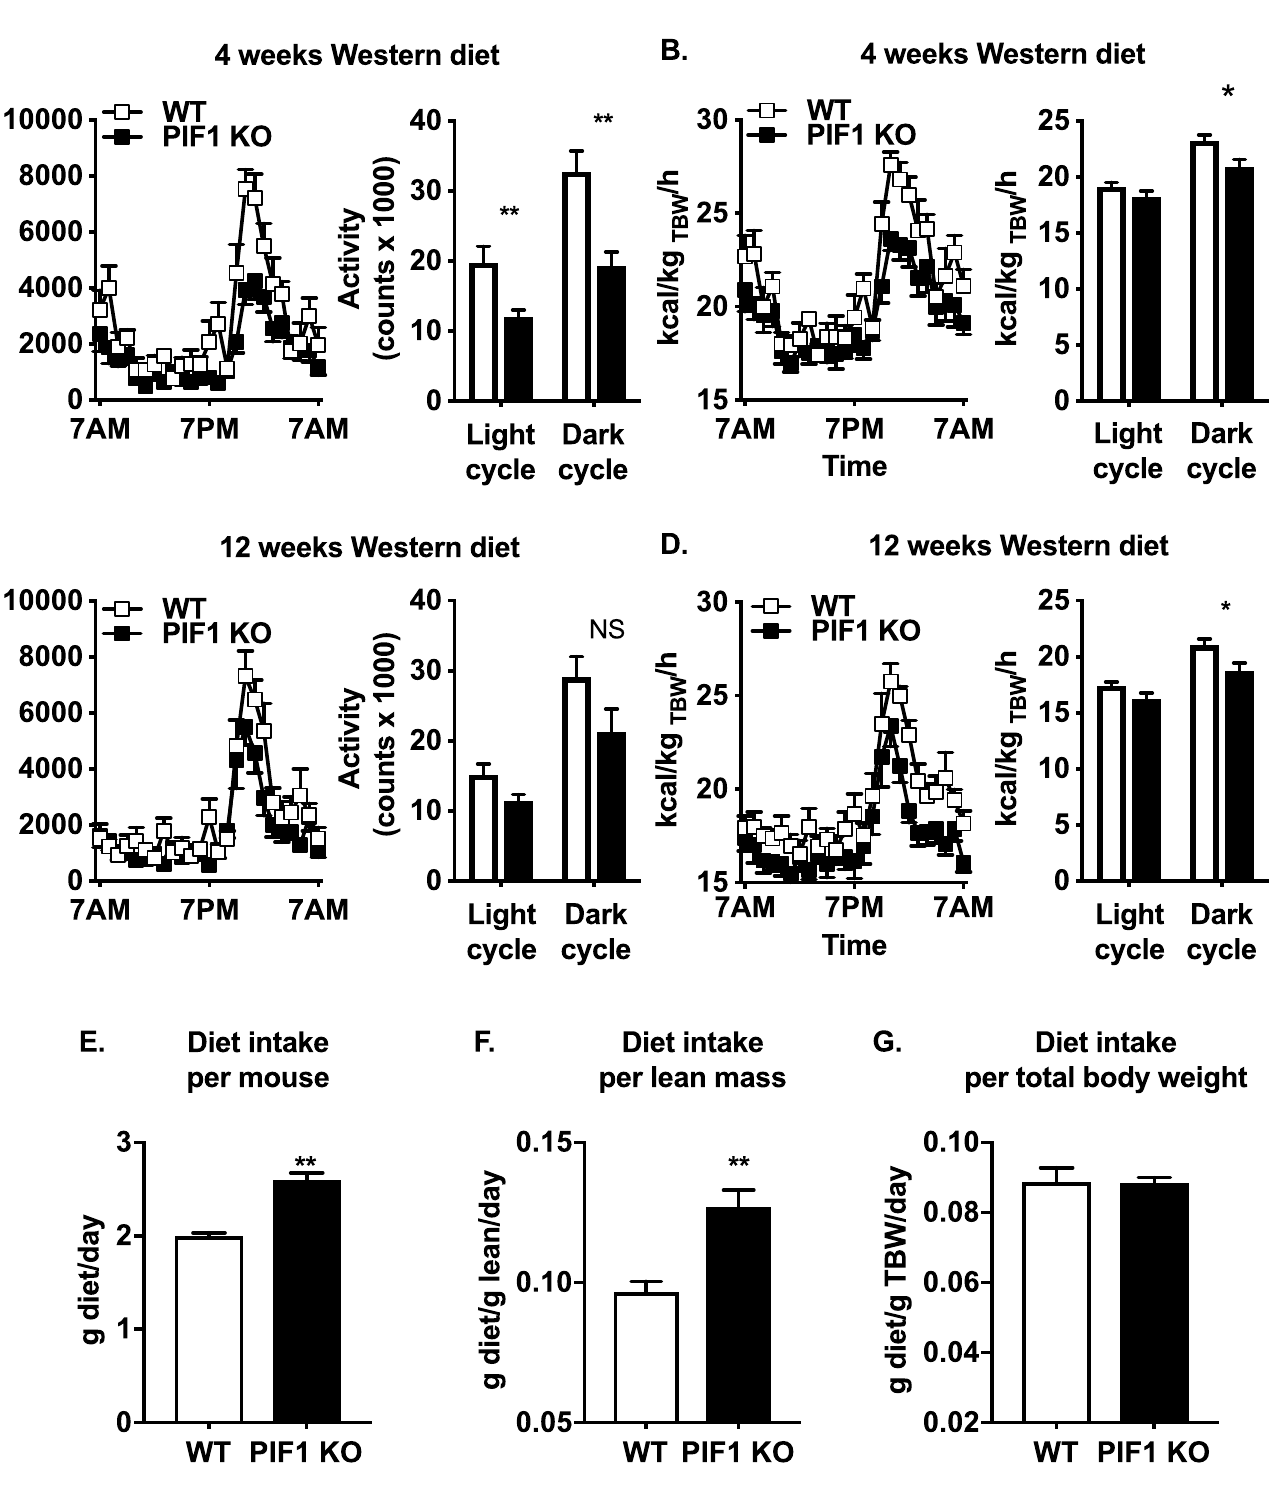
Fig 3. Long-term, Western diet (WD)-fed PIF1 KO female mice exhibited decreased locomotor activity and whole-body energy expenditure. A) Locomotor activity and B) whole-body energy expenditure measurements in 3-month-old, PIF1 KO female mice after 4 weeks of WD feeding. C) Locomotor activity and D) whole- body energy expenditure measured in 5-month-old, WD-fed PIF1 KO female mice after 12 weeks of feeding. E) WD food intake per mouse determined as the average of